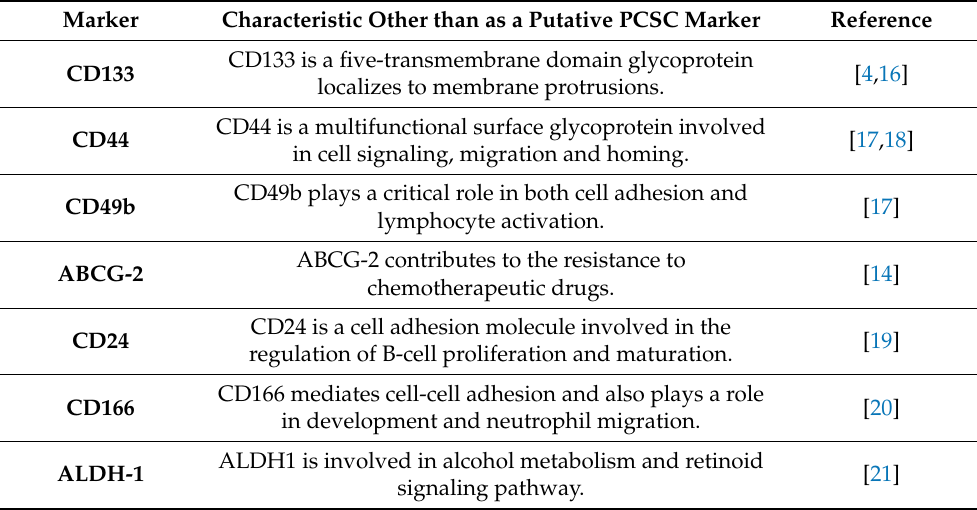
Table 1. Current Putative PCSC markers.